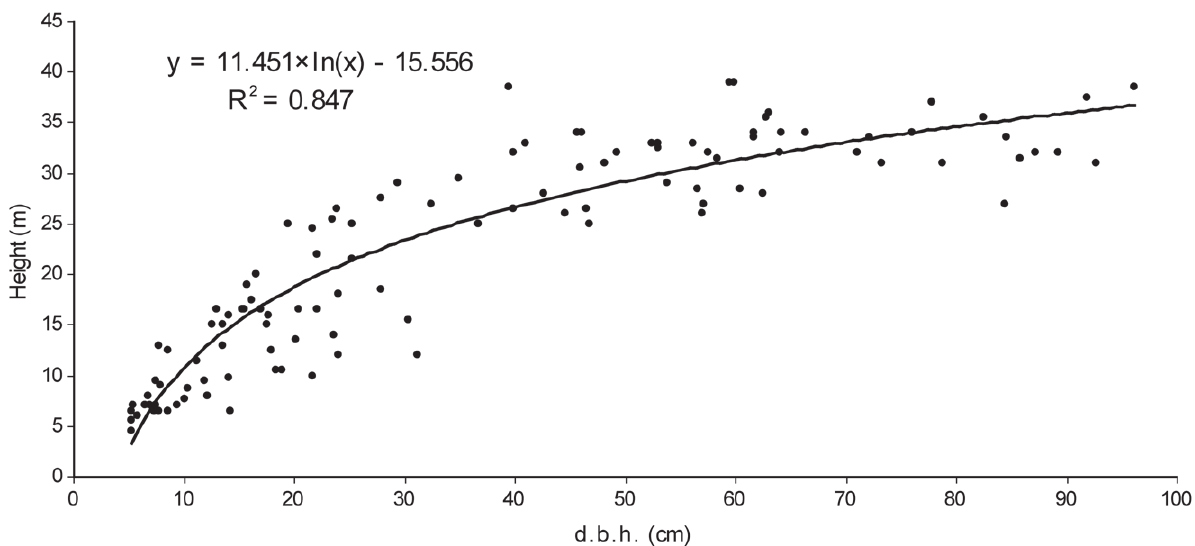
Figure 6. Height curve of beech in the Kopa and Gorjanci forest reserves. ‘‘d.b.h.’’ is diameter at breast height. doi:10.1371/journal.pone.0052641.g006 PLOS ONE |